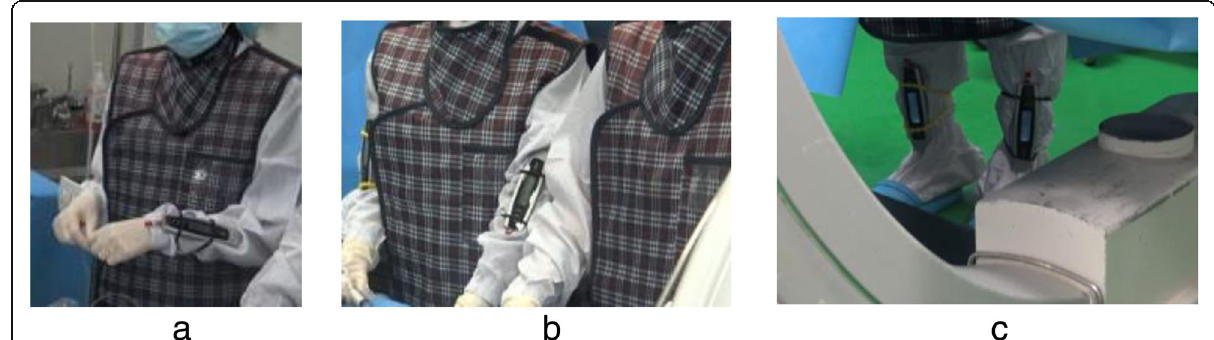
Fig. 3 Location of dosimeter for the assistant. The dosimeter is attached to various unprotected body parts of the assistant to measure radiation dose rates: a hands, b arms, c legs